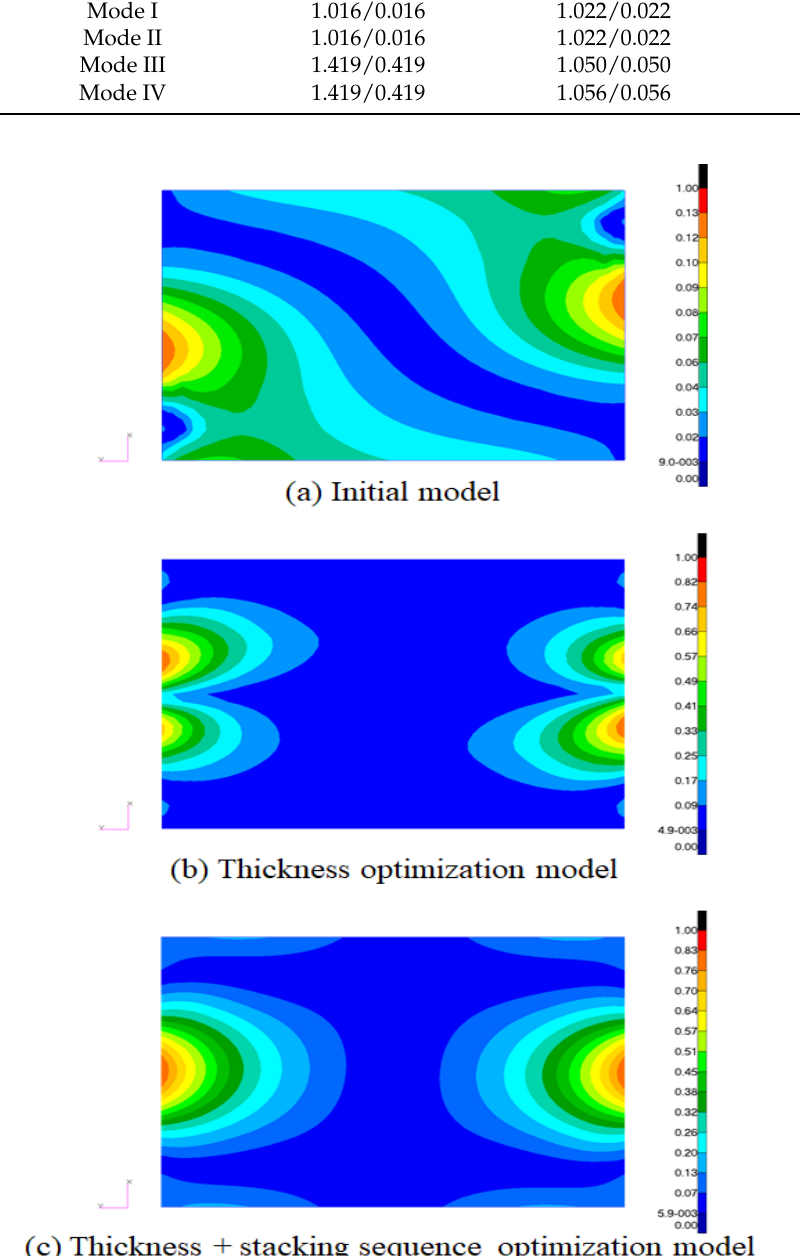
Figure 18. Comparison of Buckling results, 1st Mode. Table 4. Comparison results of each model’s stability analysis.